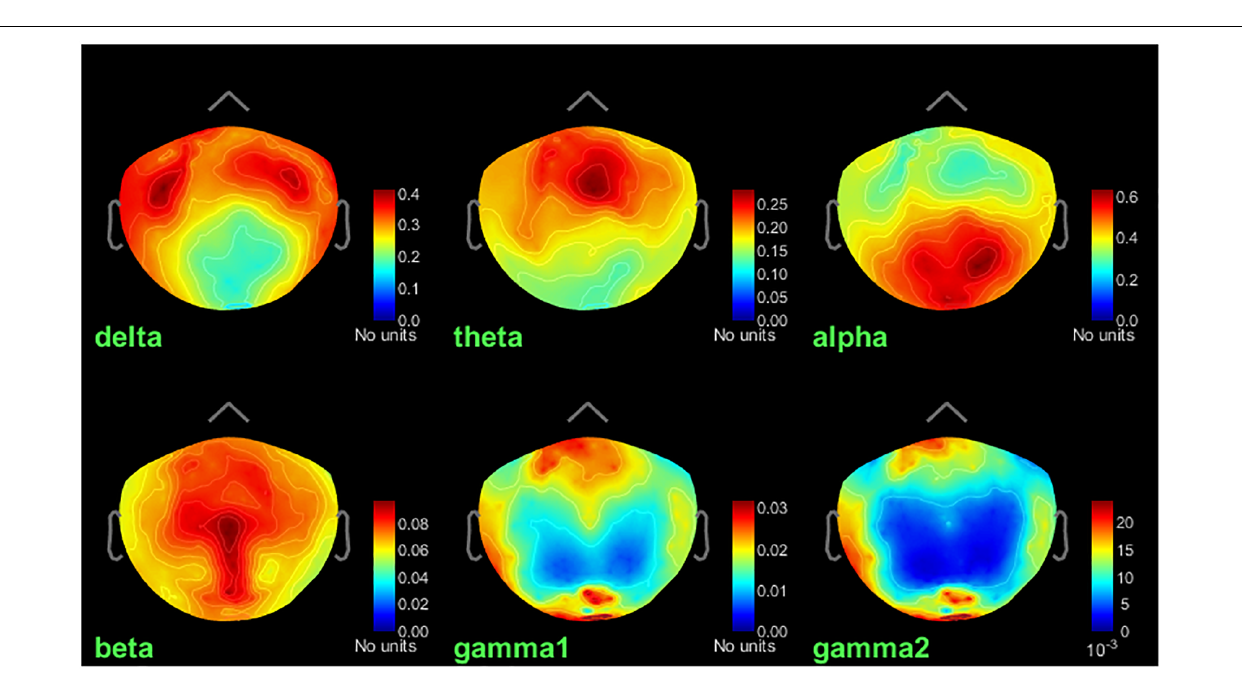
FIGURE 6 | Group average of relative PSD of sensor data for the frequency bands. Top sensor view. Values range between 0 and 1, indicating the power of cortical signals relatively to the total signal power across the frequency